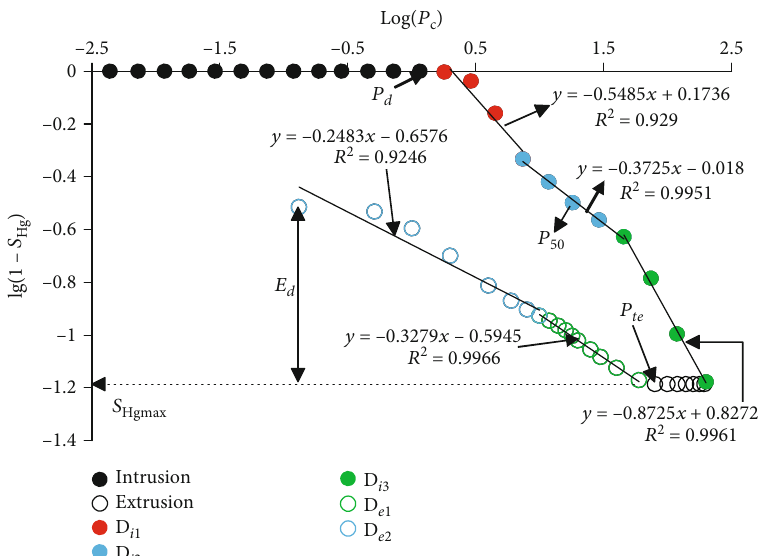
Þ vs. lg ð 1 − S Þ using HPMIP. c Hg